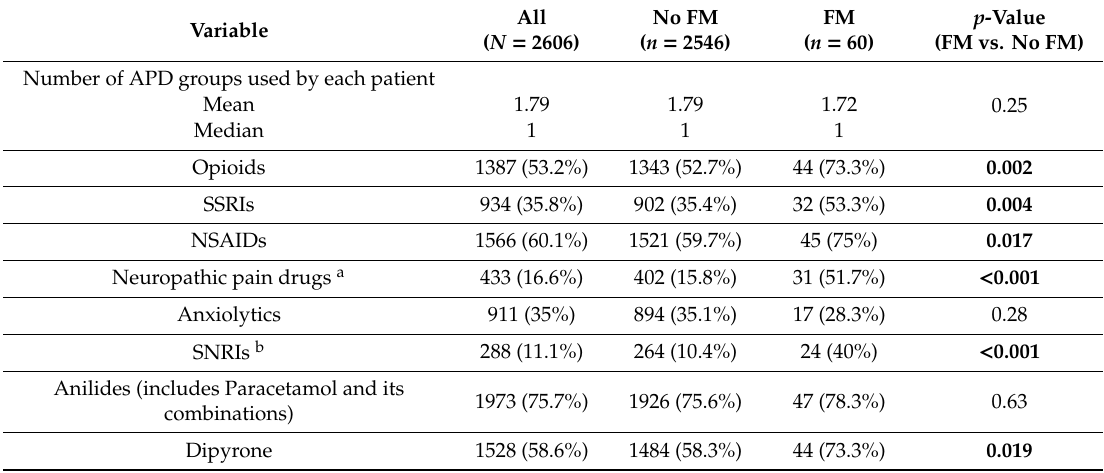
Table 2. Number of patients who purchased at least one drug of a certain group after first APD purchase.